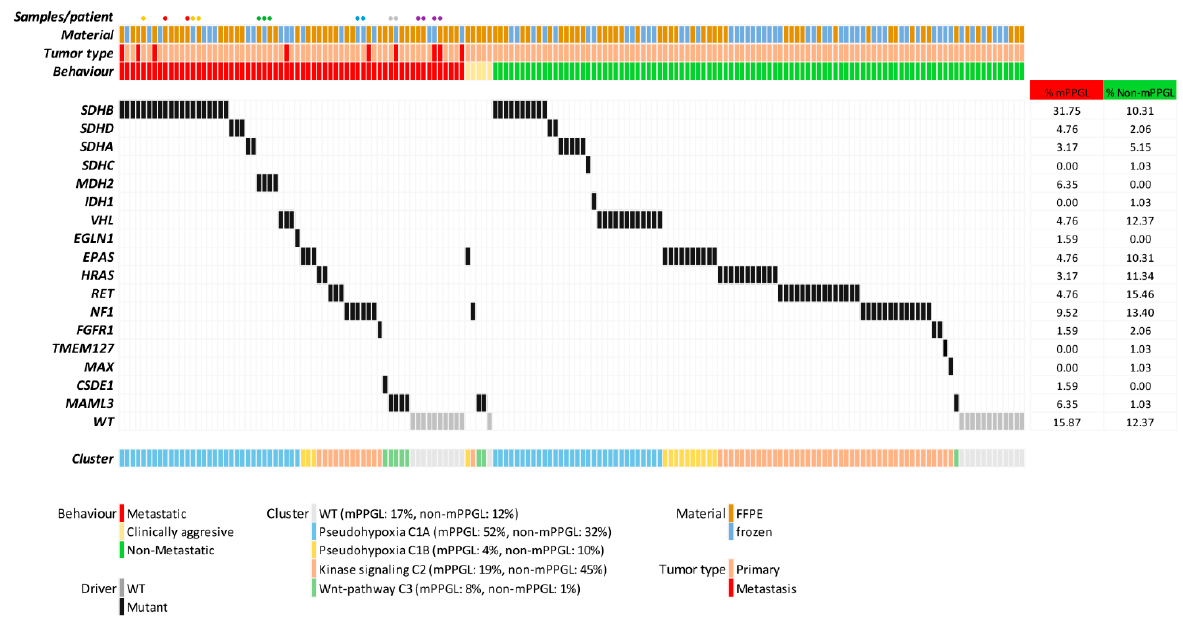
Figure 1. CNIO discovery series: genetic characterization of PPGL series: tumor driver gene and cluster classification. The frequency of each driver gene (percentage) per group, material for each sample and tumor tissue type (primary/metastasis) are shown in the figure. The colored dots represent tumors from the same patient; each color corresponds to a different patient.